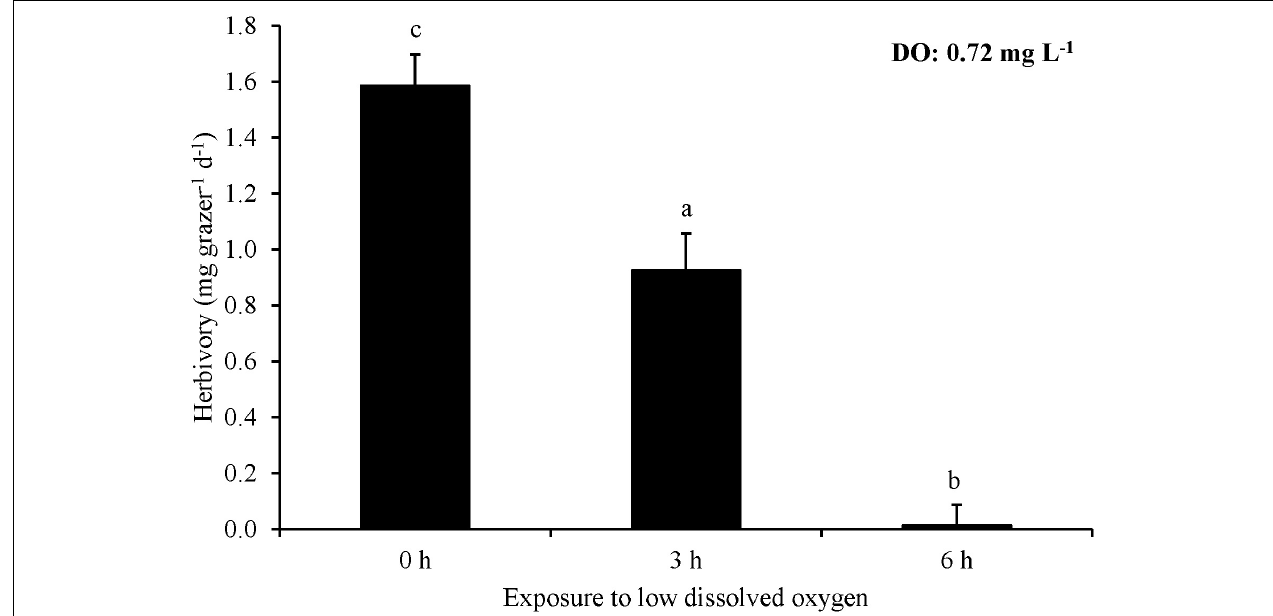
FIGURE 8 | Herbivory rates of L. vincta initially starved for 24 h under ambient pH/DO and allowed to graze on U . rigida for 6 h with varying durations of exposure (0 – 6 h) to low DO concentrations (0.72 mg L − 1 ) (Experiment 8; Table 2 ). Statistical analyses: One-way ANOVA and post hoc Tukey Honest Significant Difference tests performed; significant differences between treatments represent p -values less than 0.05.